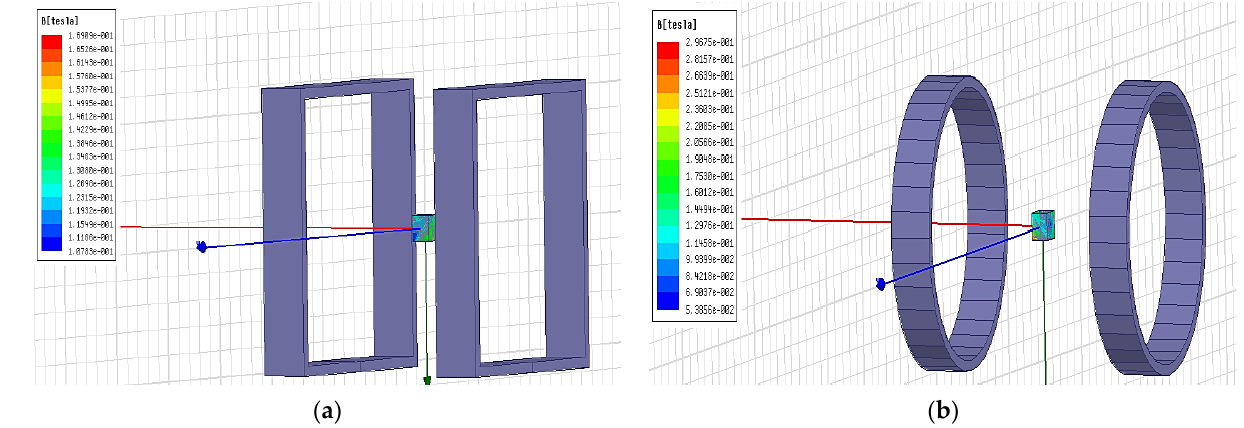
Figure 3. Cloud of magnetic induction intensity at the center of different types of coils: ( a ) Square coils; ( b ) Round coils.